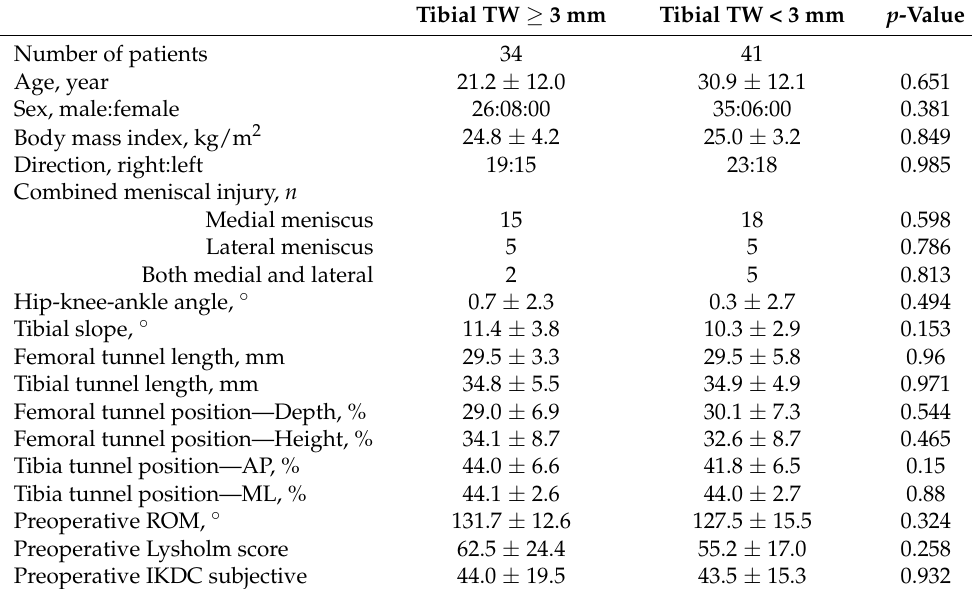
Table 5. Comparison of preoperative, immediate, and postoperative outcomes between tibial tunnel widening ≥ 3 mm group and < 3 mm